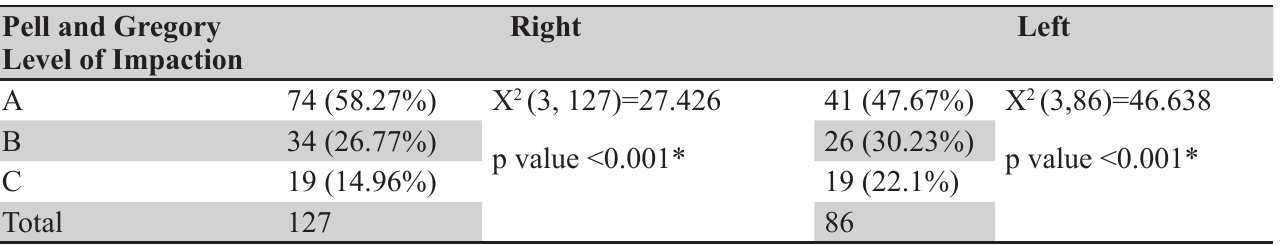
Table 4: Darkening of roots in respect to Pell and Gregory Depth/Level of Impaction of mandibular third molar. Pell and Gregory Level of Impaction